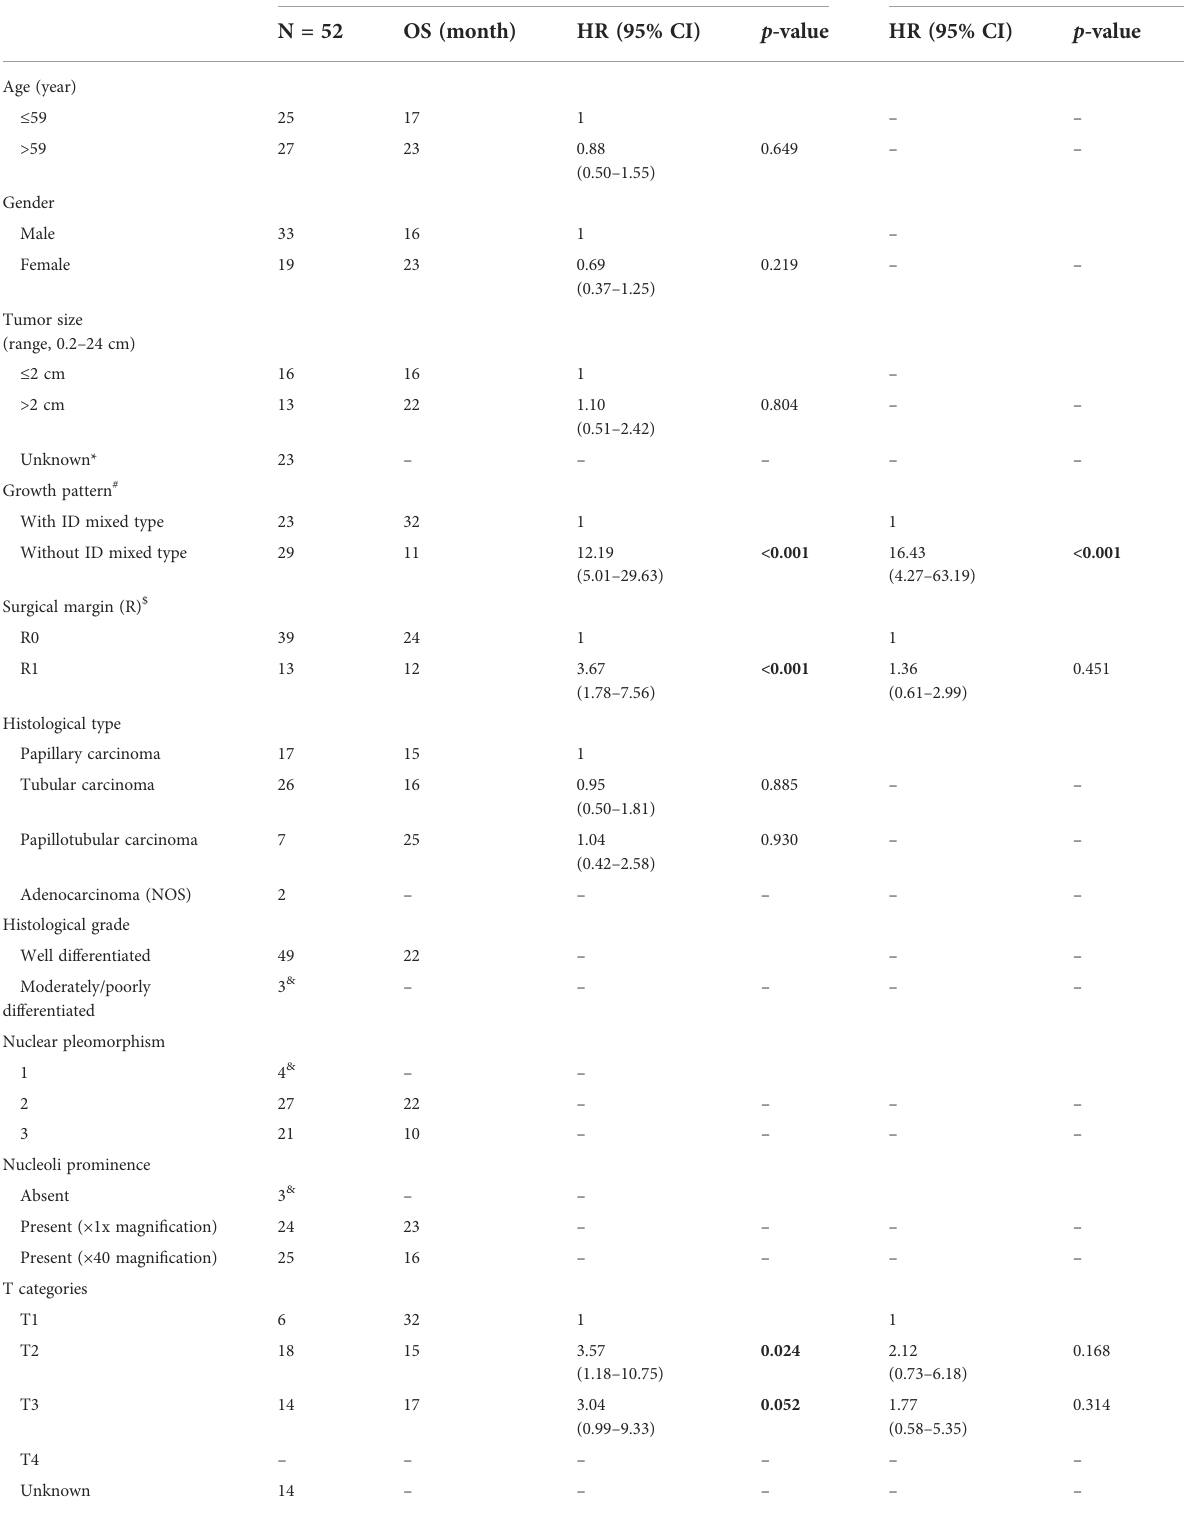
TABLE 1 Univariate and multivariate analysis of survival in patients with distal